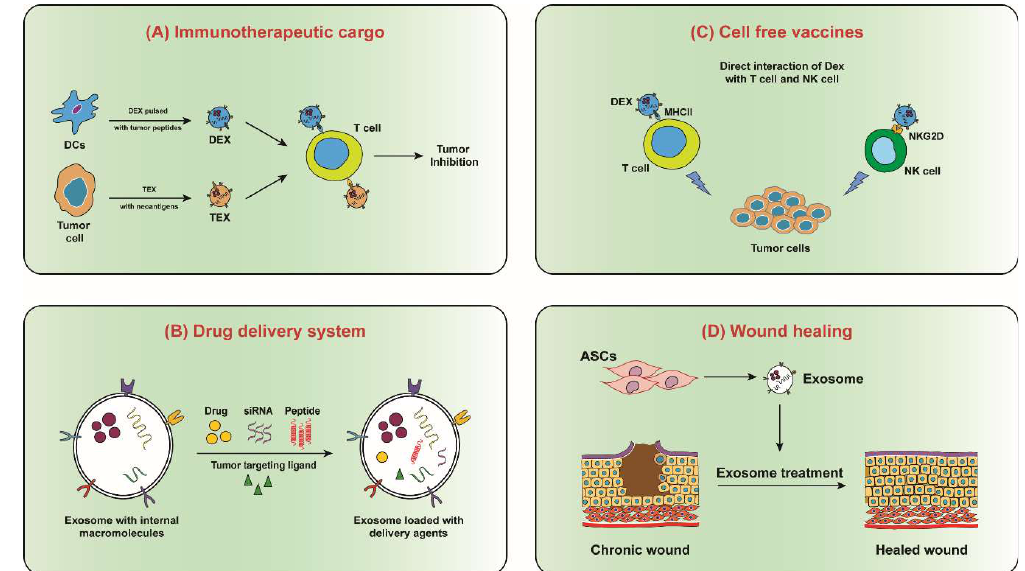
Figure 5. Therapeutic potential of exosomes. ( A ) Exosomes from dendritic cells (DEX) and tumour cells (TEX), carries immunogenic agents that can be transferred to tumour cell for immunomodulation. ( B ) Exosomes can be used as a drug delivery system in which versatile delivery agents can be loaded for disease prevention and treatment applications. ( C ) DEX may directly interact with and present antigen to T cells and NK cells in order to kill tumour cells. It is also possible that DEX may adhere to DC surfaces and directly present antigenic peptides in the context of MHC molecules. ( D ) Exosomes from adipose mesenchymal stem cells (ASCs) contributes to skin wound healing either via di ff erentiation into skin-like cells, or by promoting proliferation and migration of skin cells into the injury site by secreting exosomes. ASCs secreted exosomes can be either injected onto the wounded skin area or applied on skin wound using biofilm